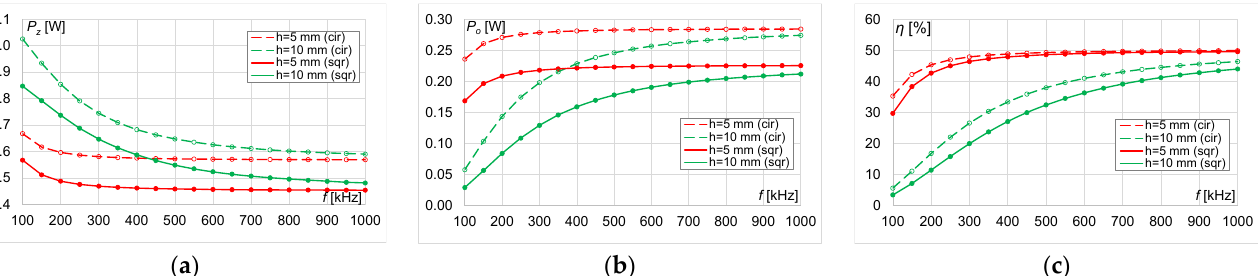
Figure 22. Results for circular and square coils with r = 10 mm and number of turns n = 45 at different distances ( h = 5 mm and h = 10 mm): ( a ) transmitter power, ( b ) receiver power and ( c ) power transfer efficiency.